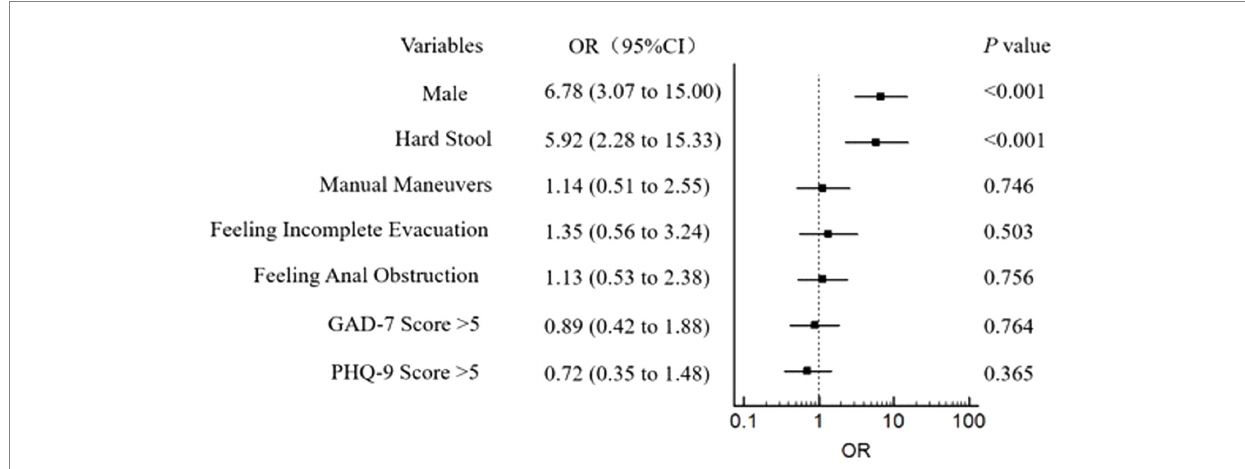
FIGURE 1 Assocaitions between RH and gender, symptoms of constipation, and mental state in 331 patients of FDD. RH: Rectal hyposensitivity; FDD: Functional defecation disorder; GAD-7: General anxiety disorder 7-item; PHQ-9: Patient health questionnaire-9. The outcome was adjusted for the potential confounding factors: age (years), BMI, and constipation